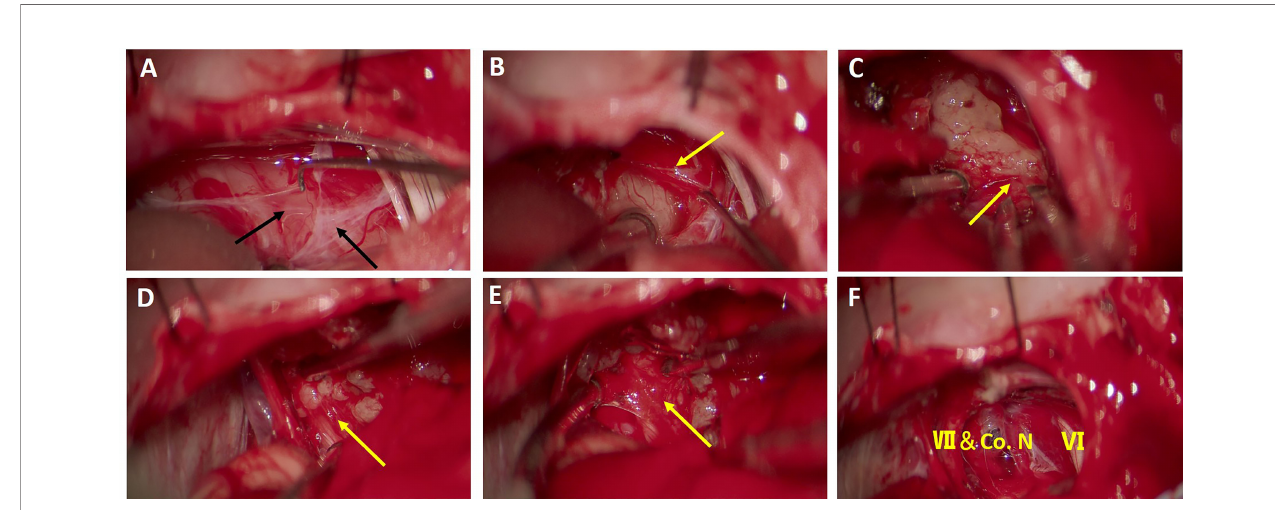
FIGURE 1 | Surgical procedure of tumor separation and removal under the perineurium. (A) An arachnoid fold consisting of the fi rst and second layers of the arachnoid membrane can be identi fi ed on the super fi cial surface of the tumor. (B) Under the arachnoid fold, the tumor capsule was identi fi ed and re fl ected under the perineural plane to create a distinguished interface for resection of the tumor. (C) The tumor was separated from the surface of the brainstem, with the perineurium remaining on the brainstem. (D) Rostrally, facial nerve was preserved under the perineurium and the tumor was dissected from the perineurium. (E) The perineurium above the facial nerve and cochlear nerve was kept intact after tumor removal. (F) Cerebellopontine angle (CPA) area after tumor removal. The brainstem, facial nerve (VII), cochlea nerve ( Co. N ), and abducens nerve (VI) were preserved well after subperineural tumor resection. Black arrows indicate arachnoid membrane and yellow arrows indicate the